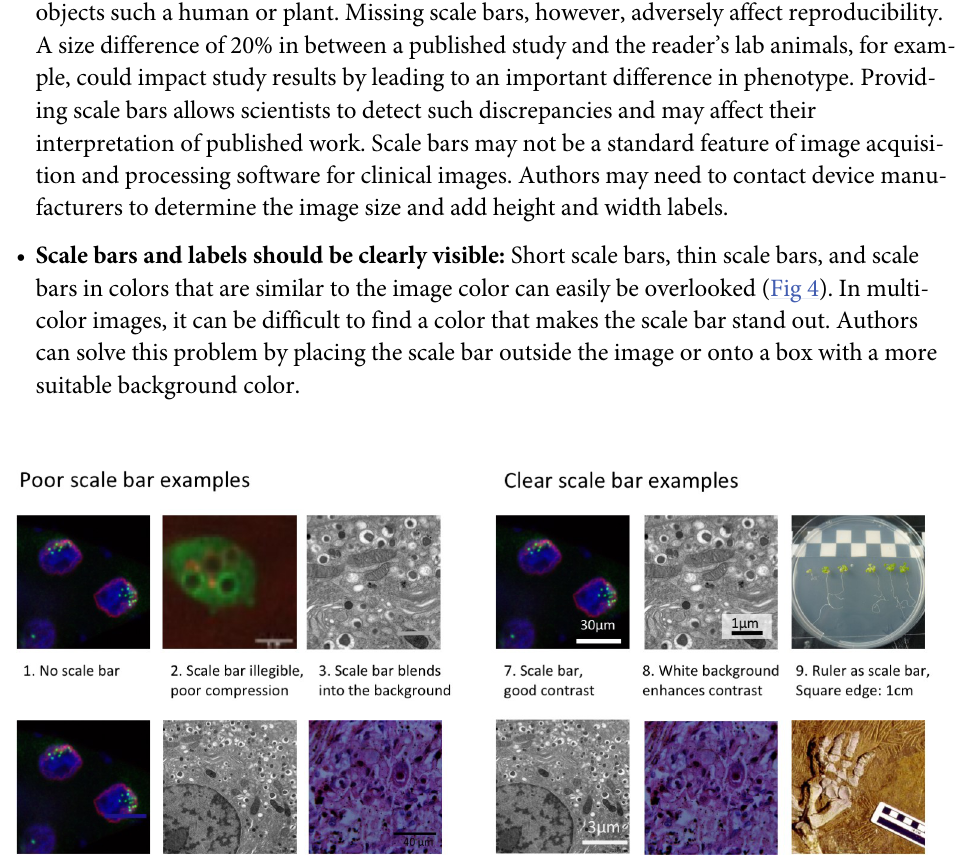
figure legend. Care must be taken when preparing figures outside vector graphics suits, as insert positions may move during file saving or export.